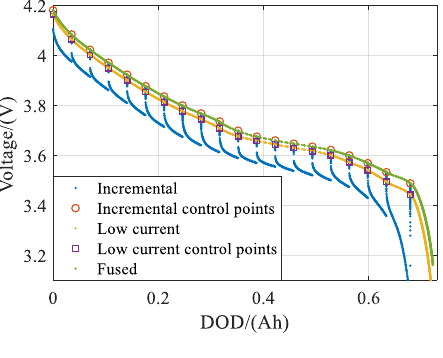
Figure 5. The OCV fusion results.